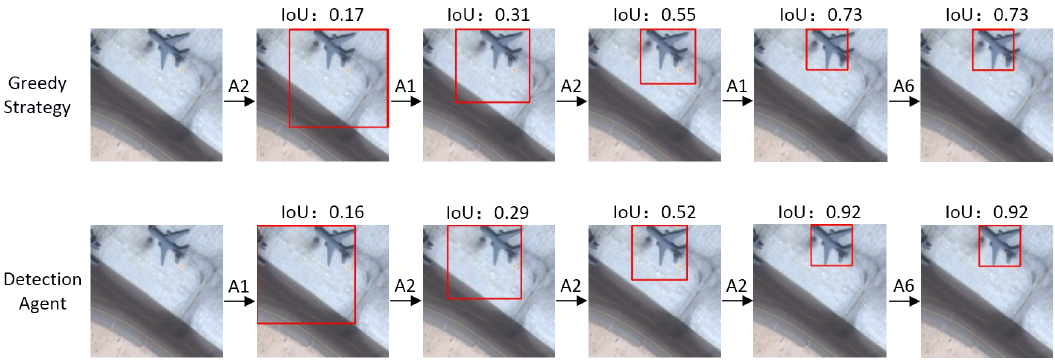
Figure 6. The first row is the action sequence and IoU based on the greedy strategy in apprenticeship learning, which is taking the action that can get the highest IoU at each time step. The second row is the action sequence and IoUs based on the detection agent, which learn according to the greedy